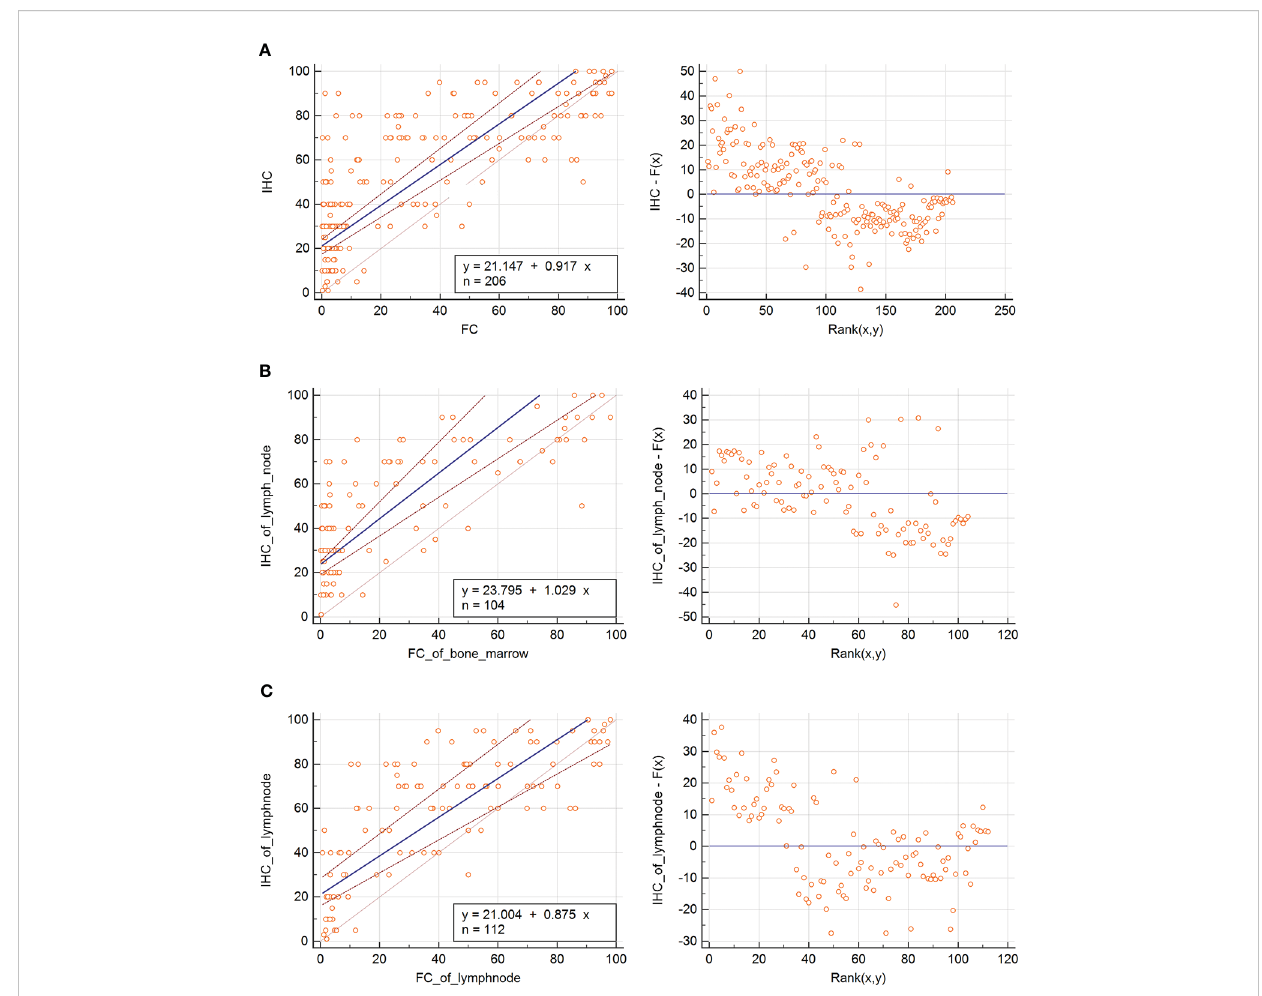
FIGURE 5 Passing-Bablock regression analysis of MFC Ki67 expression and IHC Ki67 index. (A) The Passing – Bablock linear regression analysis showed a good agreement between the two methods regardless of sample type. The formula of regression equations was: IHC = 21.147 (95% CI: 17.482 - 24.042) + 0.917 (95% CI: 0.832 - 1.027) × FC (P<0.01). (B) The Passing – Bablock linear regression analysis showed also a good agreement between Ki67 from bone marrow sample detected by FC and Ki67 from lymph node sample detected by IHC. The formula of regression equations was: IHC of lymph node = 23.795 (95% CI: 19.260 - 25.075)+ 1.029 (95% CI: 0.868 - 1.345) × FC of bone marrow (P<0.01). (C) The Passing – Bablock linear regression analysis showed also a good agreement between Ki67 from lymph node detected by FC and Ki67 from lymph node detected by IHC. The formula of regression equations was: IHC = 21.004 (95% CI: 16.060 - 28.327) + 0.875 (95% CI: 0.743 - 1.010) × FC